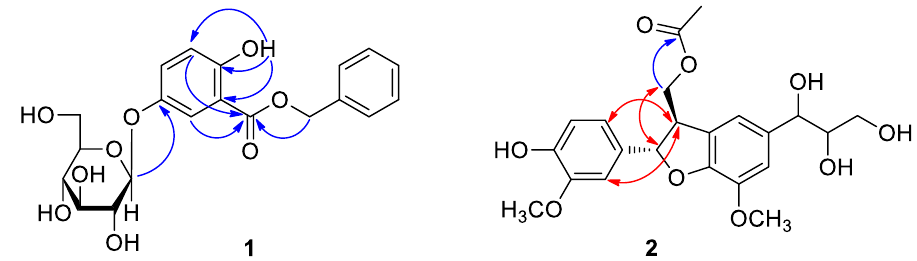
Figure 2. Key HMBC (blue arrows) and NOE (red arrows) correlations of 1 and 2 .